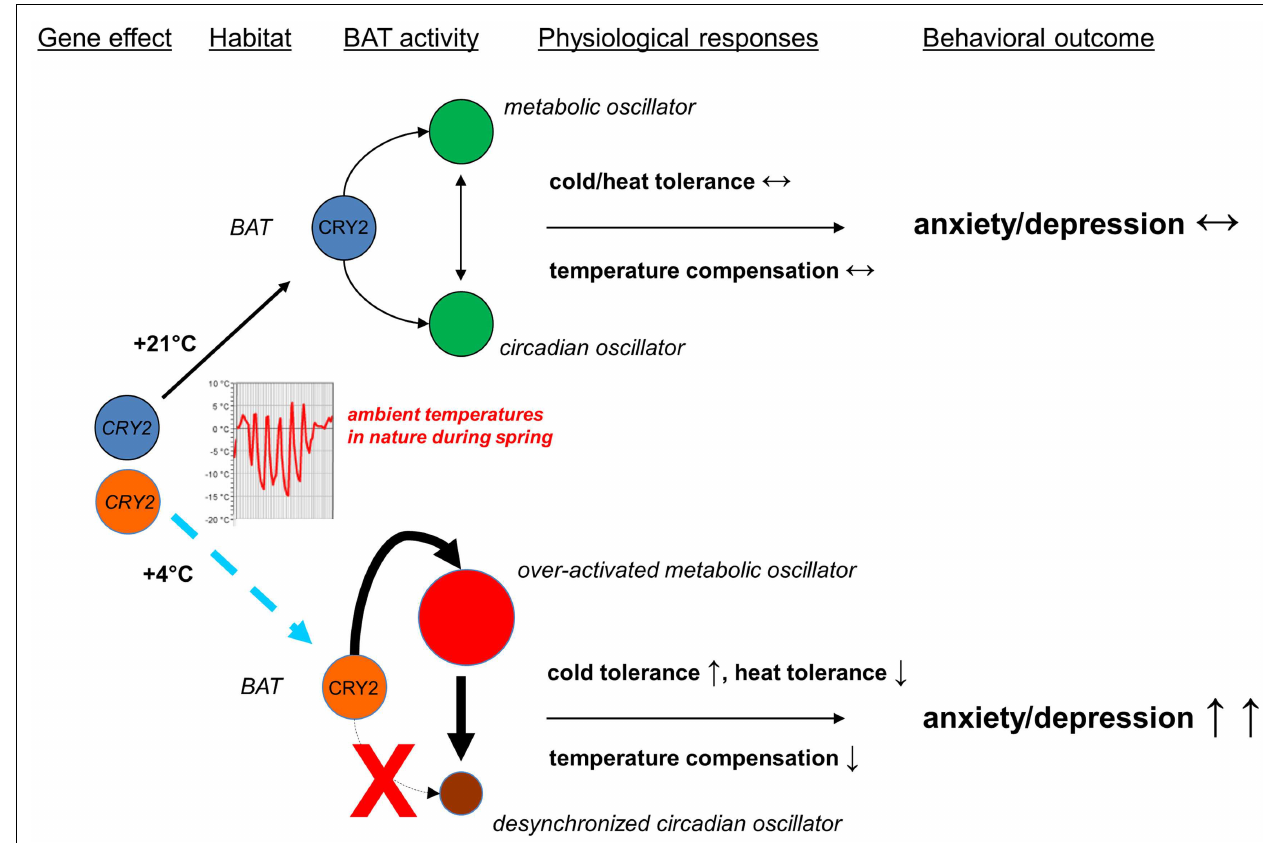
post-translational control of CRY2, brown adipose tissue is over-activated easily. It is currently not known, whether this kind of over-activation of brown adipose tissue, hypothesized to lead to the increased cold tolerance but to cause defect in tolerance to heat, characterizes mood disorders and anxiety disorders, and whether it contributes to the seasonal peaks in their occurrence and mortality rates for deaths from suicide, but it needs to be tested against experiments and